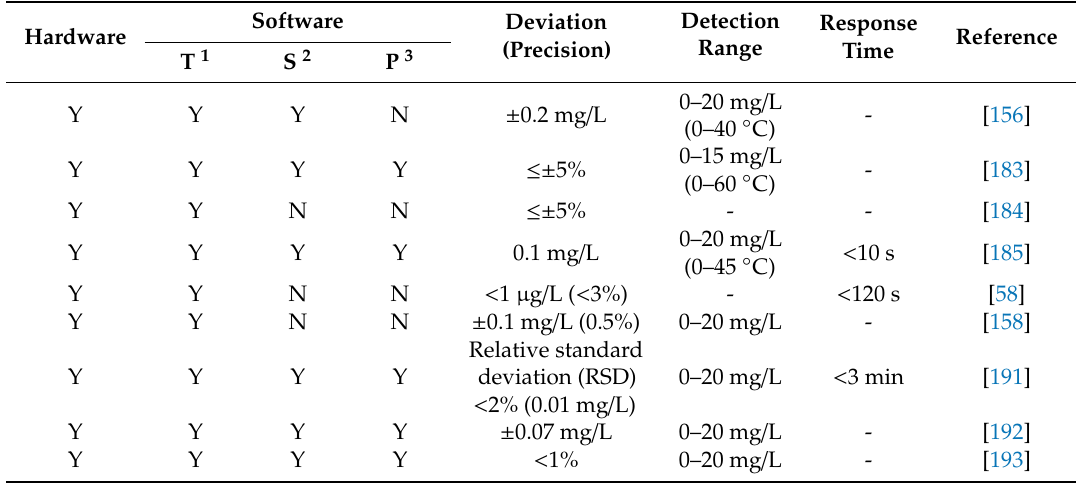
Table 5. Comparison of adaptive dynamic compensation correction